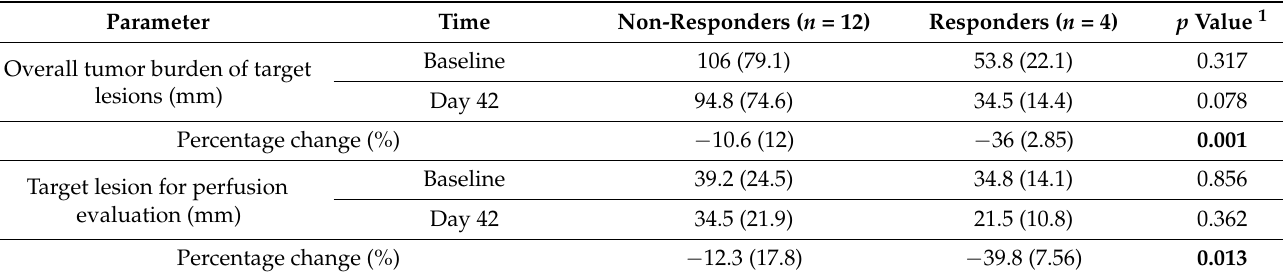
Table 4. RECIST assessments in non-responder and responder patients. Mean values are shown, with the standard deviation in